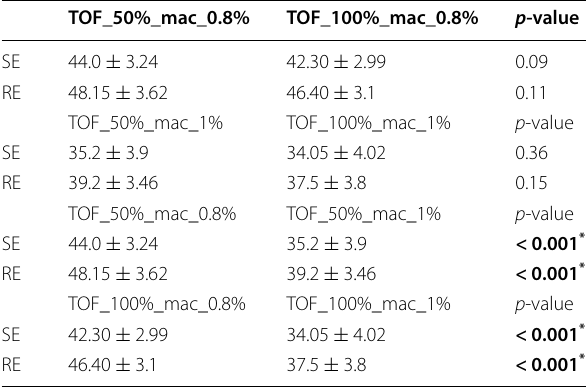
* Indicates comparison between mac 0.8 and mac 1% showed significant value at both TOF 50% and